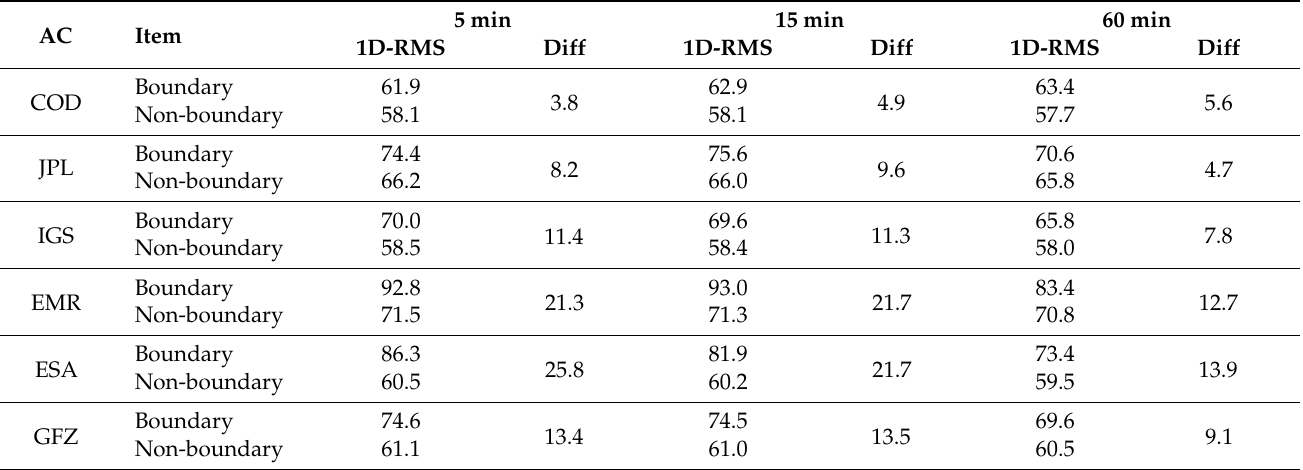
Table 3. 1D-RMS boundary and non-boundary accuracy statistics (unit: